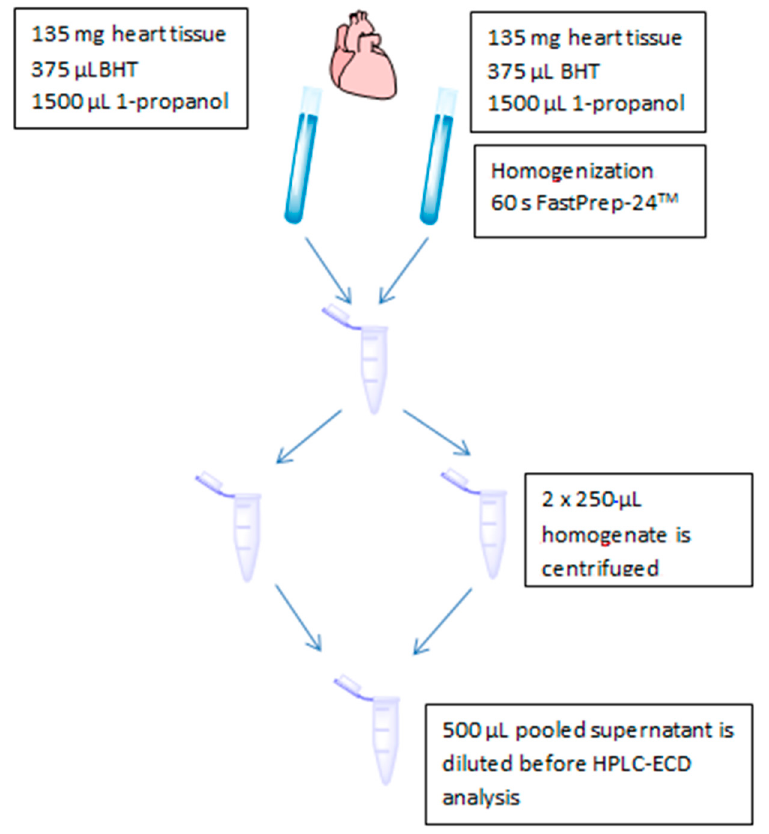
Figure 1. Schematic overview of heart tissue sample preparation before quantification of reduced and oxidized Q 10 with HPLC-ECD.